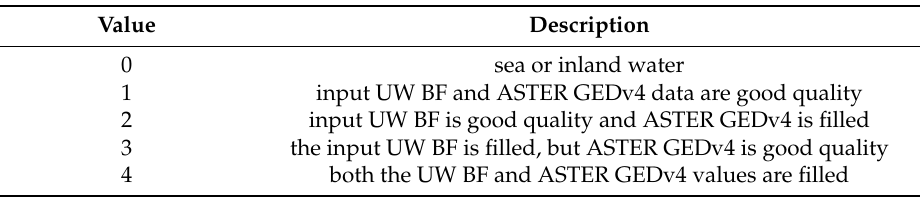
Table 3. Definition of the CAMEL emissivity quality